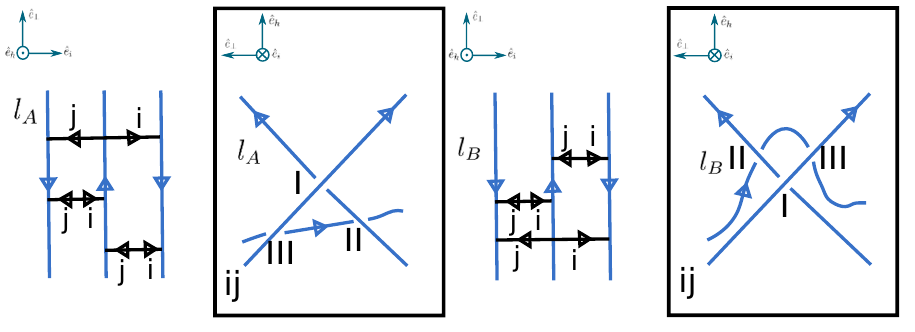
Figure 54 . The third Reidemeister